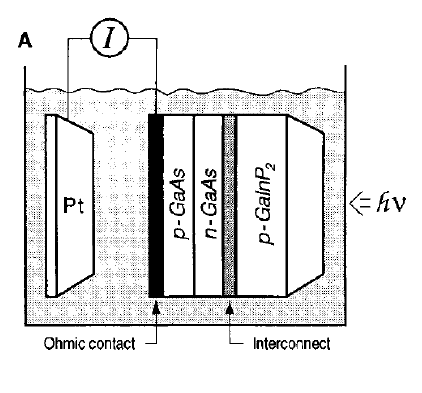
Figure 12. Structure of the hybrid planar photoelectrode (photoactive semiconductor/ITO/solid-state multi-junction/ stainless steel/HER catalyst) for water